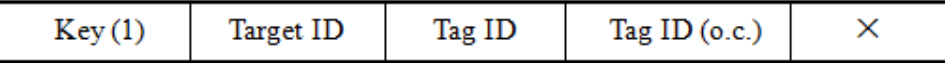
Figure 6. RFID tag’s response signal format for counting outside links.